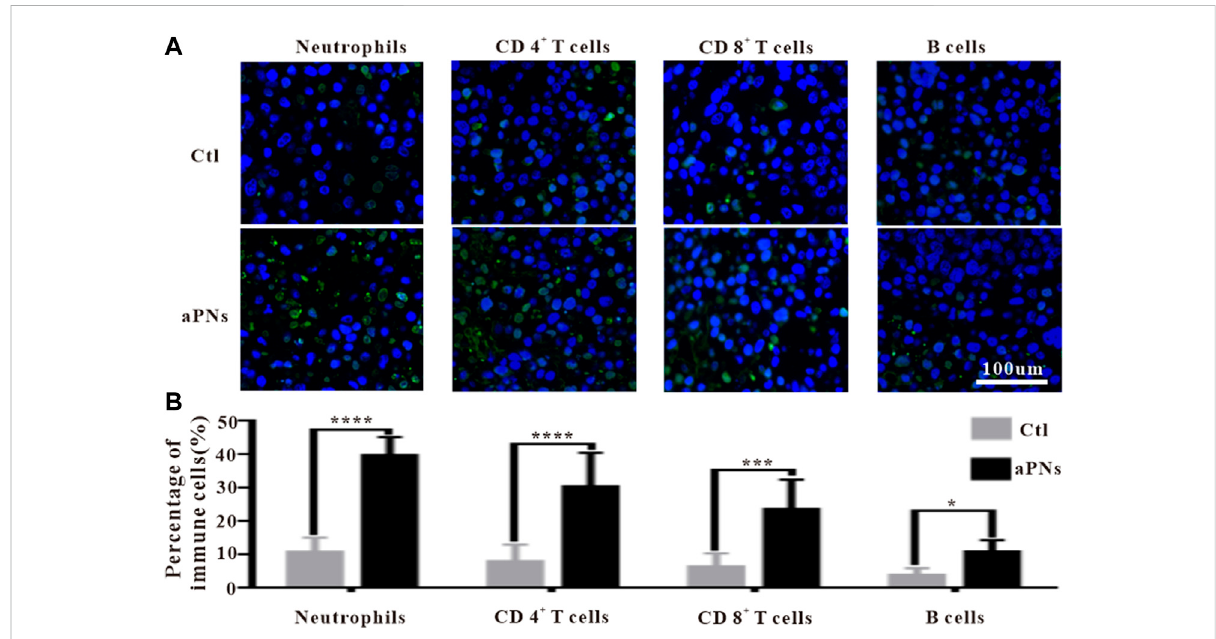
FIGURE 4 Immuno fl uorescence images of immune cells. Ctl: control; aPNs: aPLTm nanovesicles. (A) Immuno fl uorescence images of neutrophils, CD4 + T cells, CD8 + T cells, and B cells, scale bar: 100 μ m. (B) Statistical analysis of immune cells, compared with control: p p < 0.05, ppp p < 0.001, and pppp p < 0.0001.